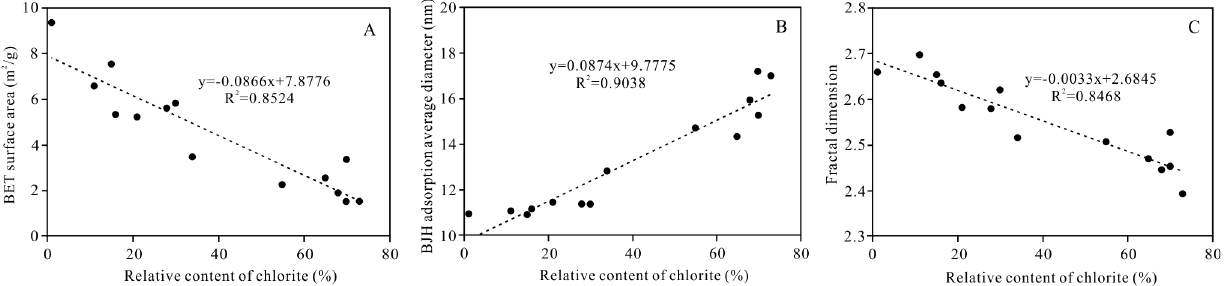
Figure 16. Relationship between the relative content of chlorite and ( A ) BET surface area, ( B ) BJH adsorption pore average diameter, and ( C ) fractal dimension.